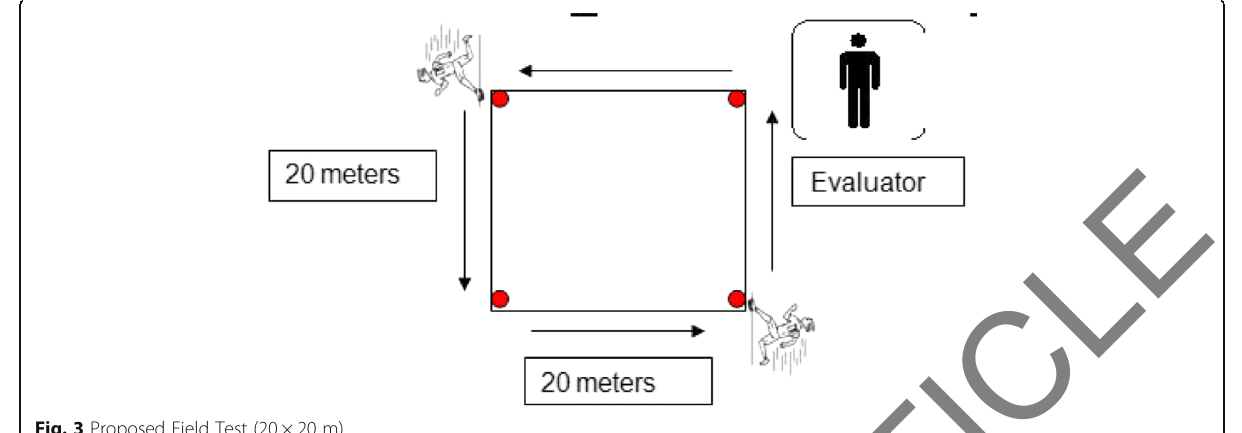
Fig. 3 Proposed Field Test (20 × 20 m)